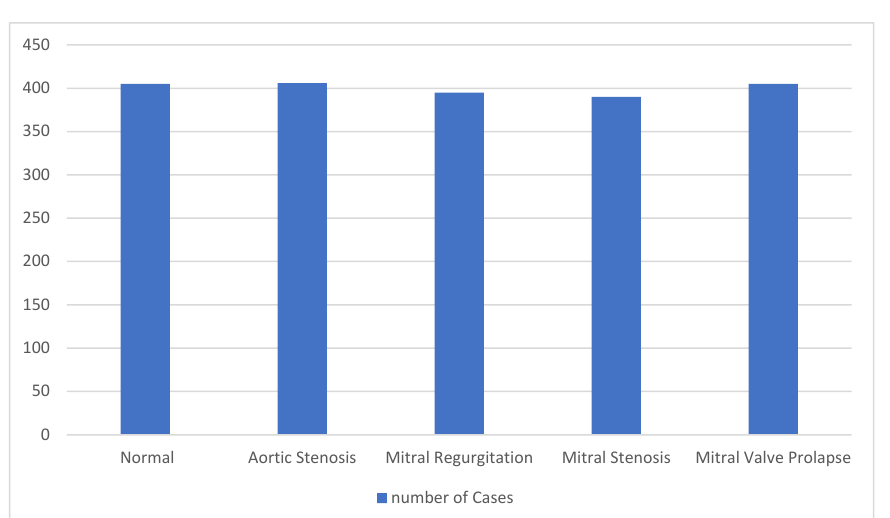
Figure 3. Distribution of the dataset.